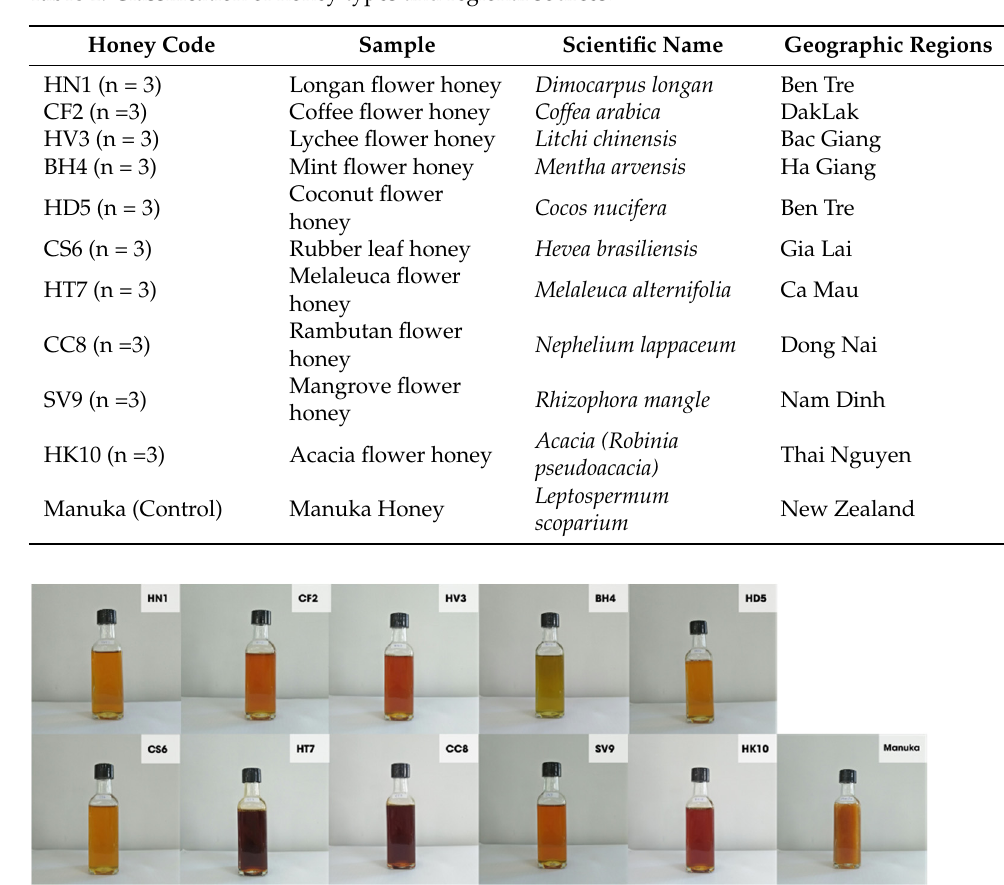
Table 1. Classification of honey types and regional sources.